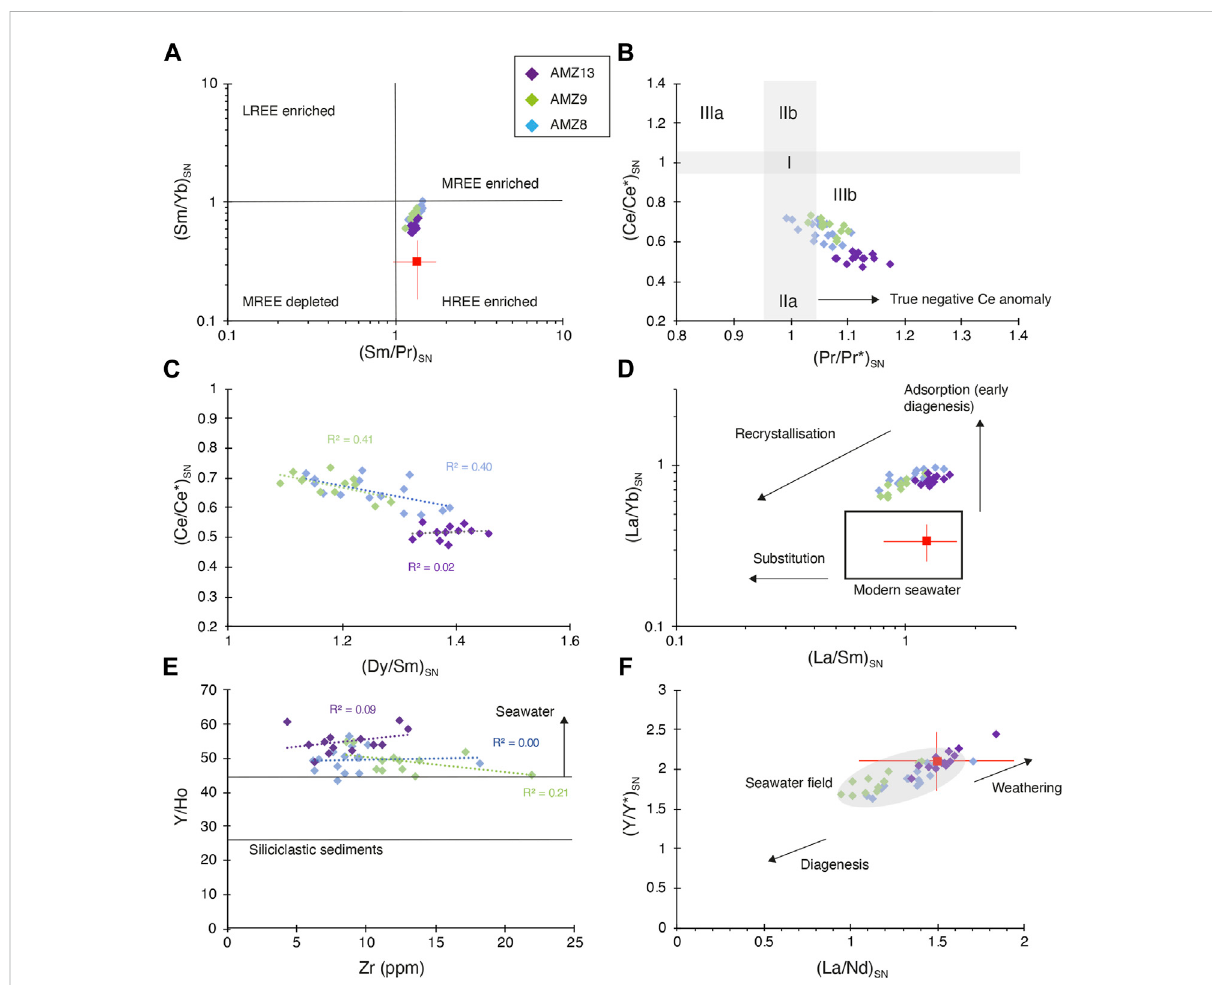
FIGURE 7 REEY cross-plots highlighting the effect of both depositional setting and diagenesis. Mean REEY SN value (n = 22, 1 σ ) of unaltered, Plio- Quaternay Namibian phosphorites is shown by the red square (Lumiste et al., 2019). (A) (Sm/Yb) SN vs. (Sm/Pr) SN , after Garnit et al. (2012). Light (La to Nd), Middle (Sm to Dy), and Heavy (Ho to Lu) REE referred to as LREE, MREE, and HREE, respectively. (B) Ce anomaly vs. Pr anomaly, after Bau and Dulski (1996). Field (I) no La and Ce anomalies; Fields IIa and IIb: apparent negative and positive Ce causedby positive and negative La anomaly, respectively; Fields IIIa and IIIb: true positive and negative Ce anomaly, respectively. (C) Ce anomaly vs. (Dy/Sm) SN , after Shields and Stille (2001). (D) (La/Yb) SN vs. (La/Sm) SN , after Reynard et al. (1999). (E) Y/Ho vs. Zr, after Bolhar et al. (2004). (F) Y anomaly vs. (La/Nd) SN , after Shields and Stille (2001). PAAS values are from Taylor and McLennan